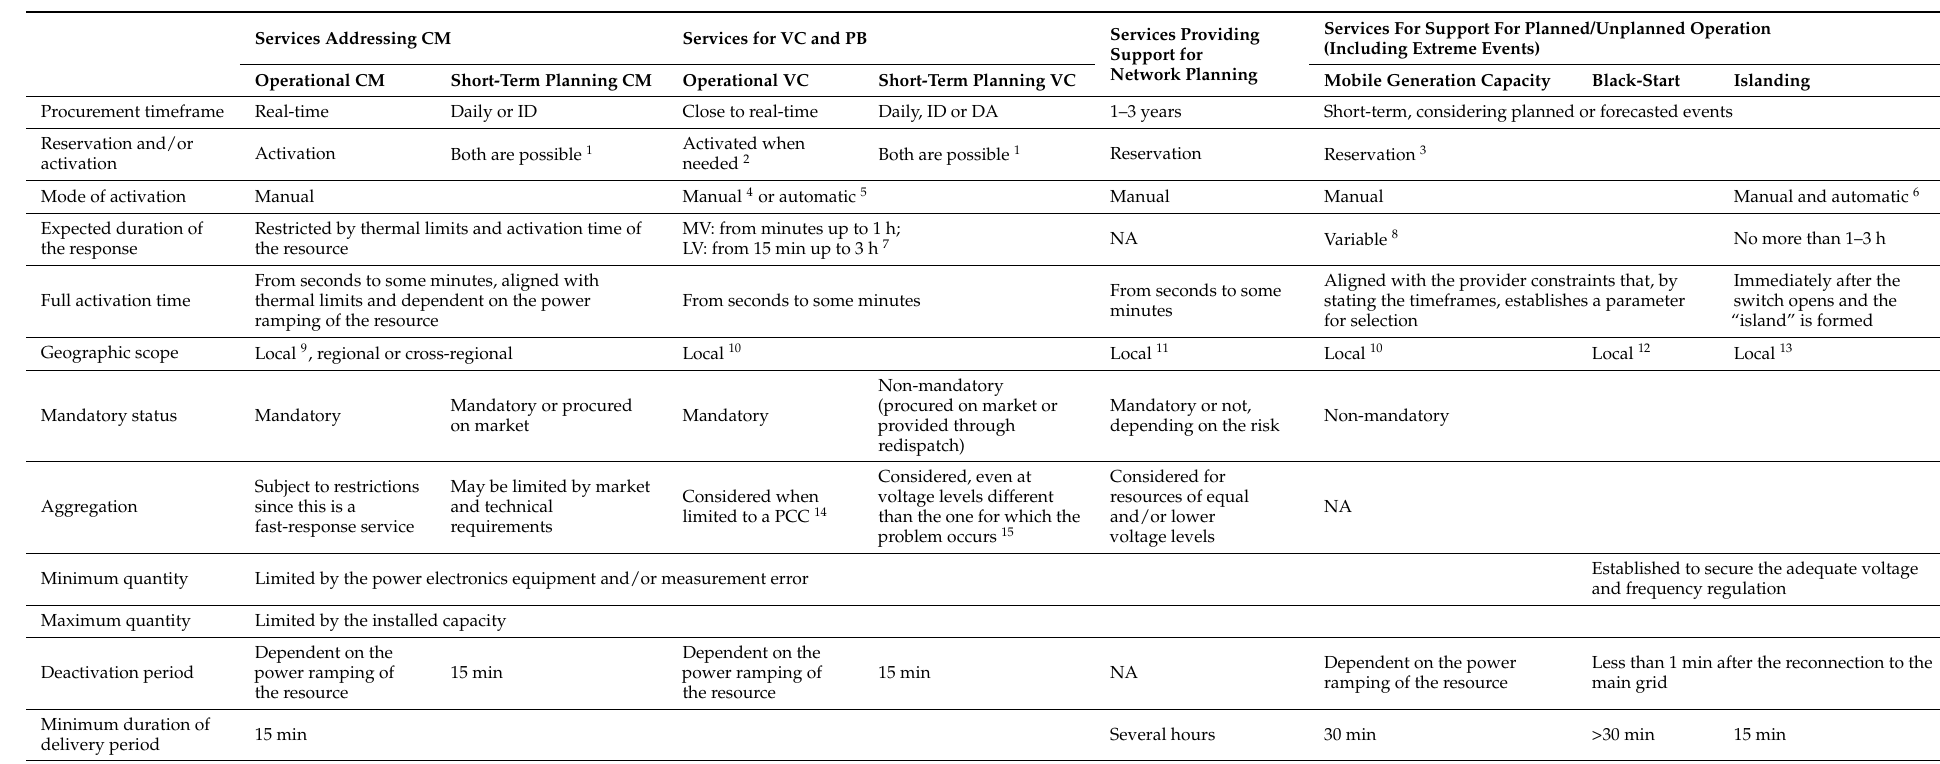
Table 6. Basic specifications of each identified service